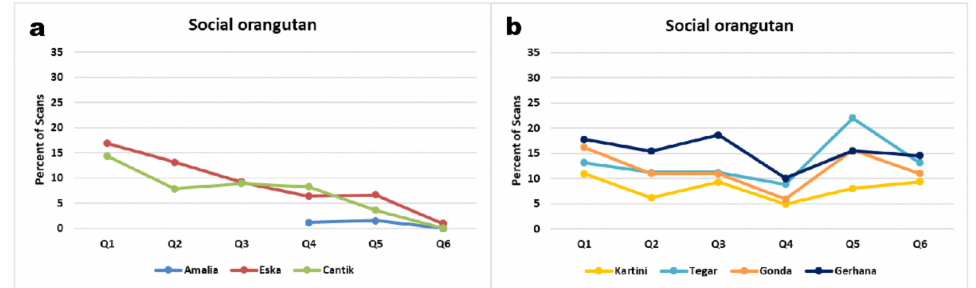
Figure 6. Development over time of social interaction frequency per juvenile ( a ) and infant ( b ) summarized across all conspecific peers. Same data base as Figure 3.